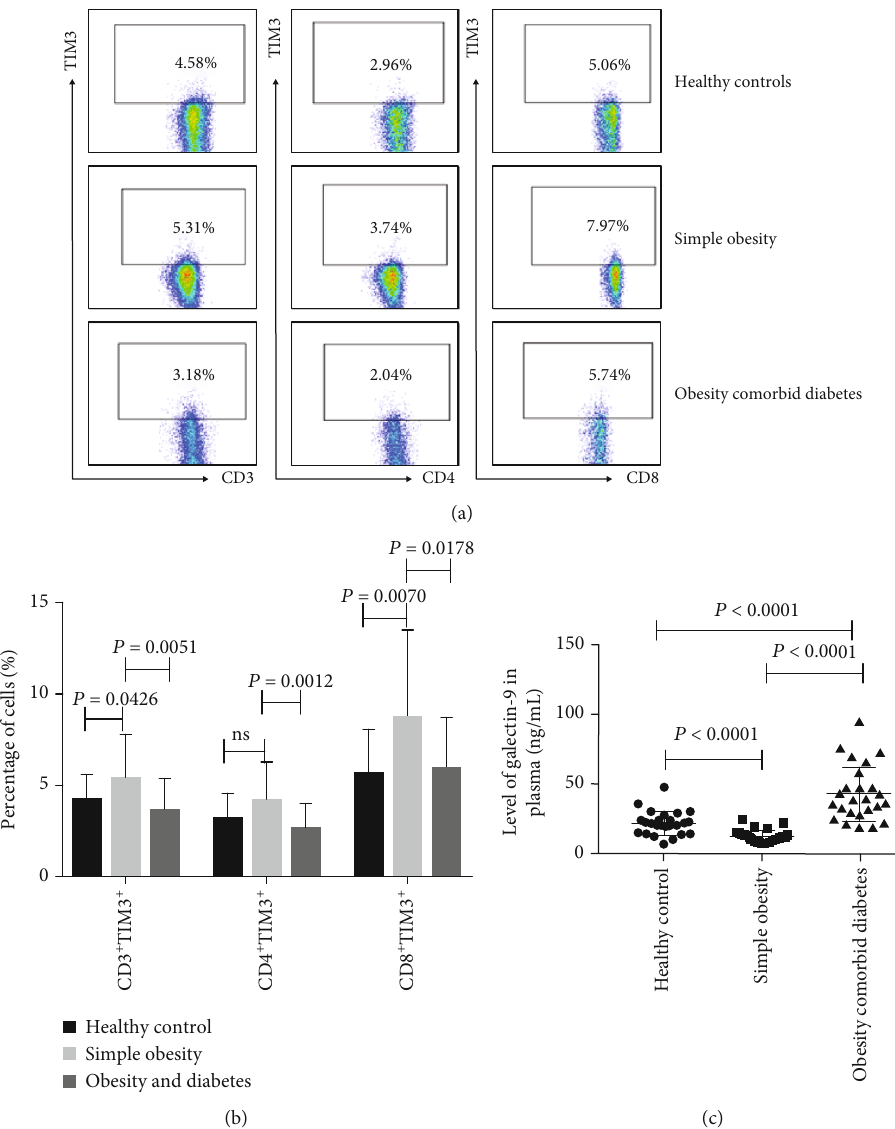
Figure 1: TIM3 and galectin-9 expression in healthy controls, obesity, and obesity-related diabetes patients. (a) The expression level of TIM3 was detected by the fl ow cytometry of CD3 + , CD4 + , and CD8 + T cells from the HC, OB, and OD groups. (b) Percentages of CD3 + TIM3 + , CD4 + TIM3 + , and CD8 + TIM3 + cells in the PBMC samples of patients from the HC, OB, and OD groups. (c) Expression of galectin-9 in the plasma of the HC, OB, and OD